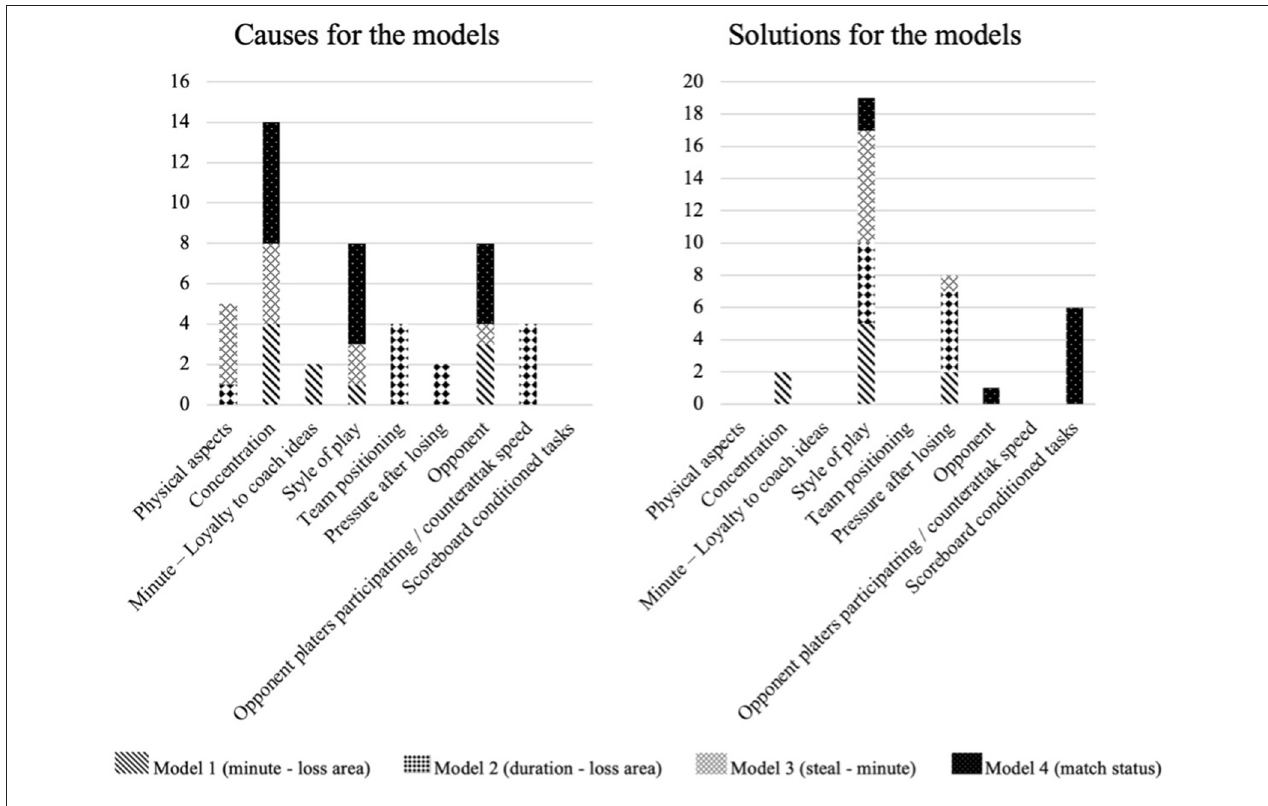
FIGURE 3 | Frequency of causes and solutions in all four predictive models.